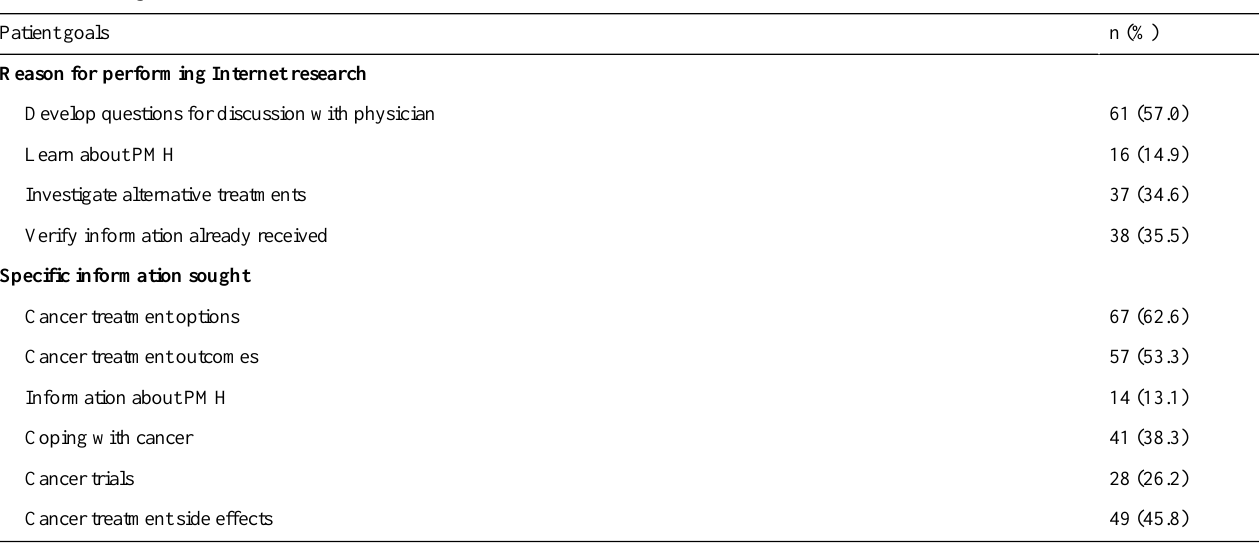
Table 3. Patient goals for Internet